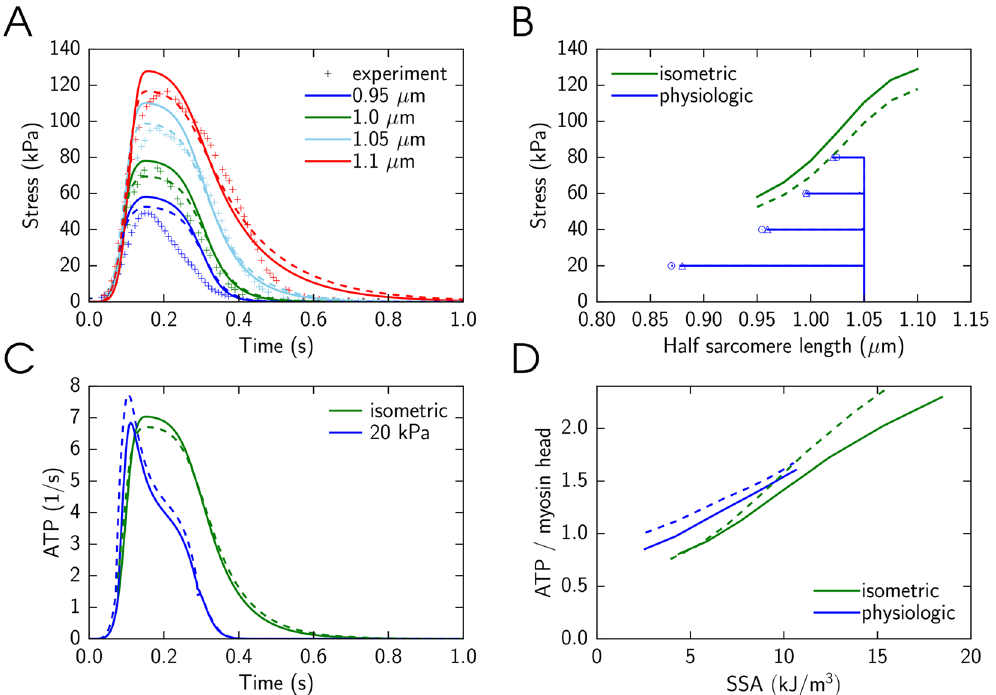
Fig 3. Use of the model with cooperativity between cross-bridges to simulate dynamic properties of the heart muscle contraction. Here, the solutions obtained with three interacting cross-bridges ( q = 3, solid line) or a single cross-bridge ( q = 1, dashed line) are shown. In these simulations, the model parameters were found by fitting model solution against the experimental data. A: Isometric contraction as a function of time at different half-sarcomere lengths from 0.95 μ m to 1.1 μ m compared with experimental measurements [20]. Sarcomere length is encoded in color, as indicated in the inset. B: End- systolic relationship between sarcomere length and stress for the isometric contractions are shown. In addition, changes in sarcomere length and developed stress are shown for physiologic contraction with the end-systolic value indicated by triangle ( q = 3) or circle ( q = 1) at different afterloads from 20 kPa to 80 kPa. C: ATP consumption by a cross-bridge during isometric and physiological contractions (20 kPa). Note how the difference in afterload changes ATP consumption by a cross-bridge. Here, simulations are shown for half-sarcomere end-diastolic length of 1.05 μ m. D: Total amount of consumed ATP molecules per myosin head during a cardiac cycle as a function of SSA for isometric and physiologic contractions. Note that the both models reproduce the linear relationship between SSA and energy consumption.